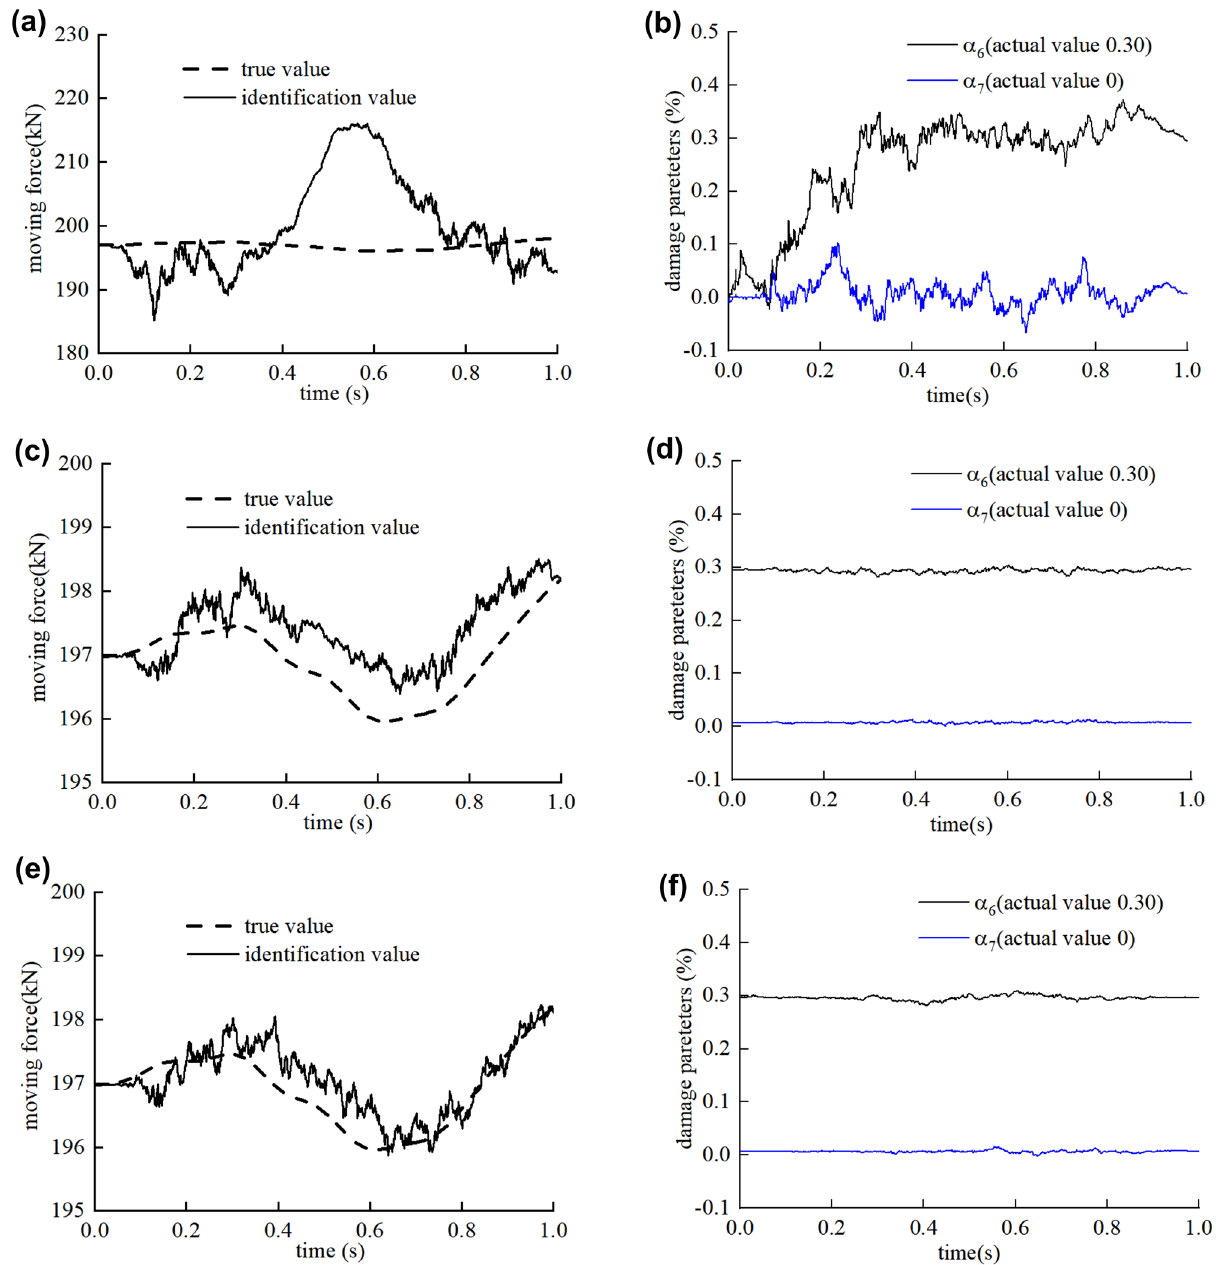
Figure 4. The identification results of the contact moving force in the ( a ) initial iterative process, ( c ) second iterative process, ( e ) third iterative process and the identification results of damage parameters at the node No. 6 and No. 7 in the ( b ) initial iterative process, ( d ) second iterative process, ( f ) third iterative